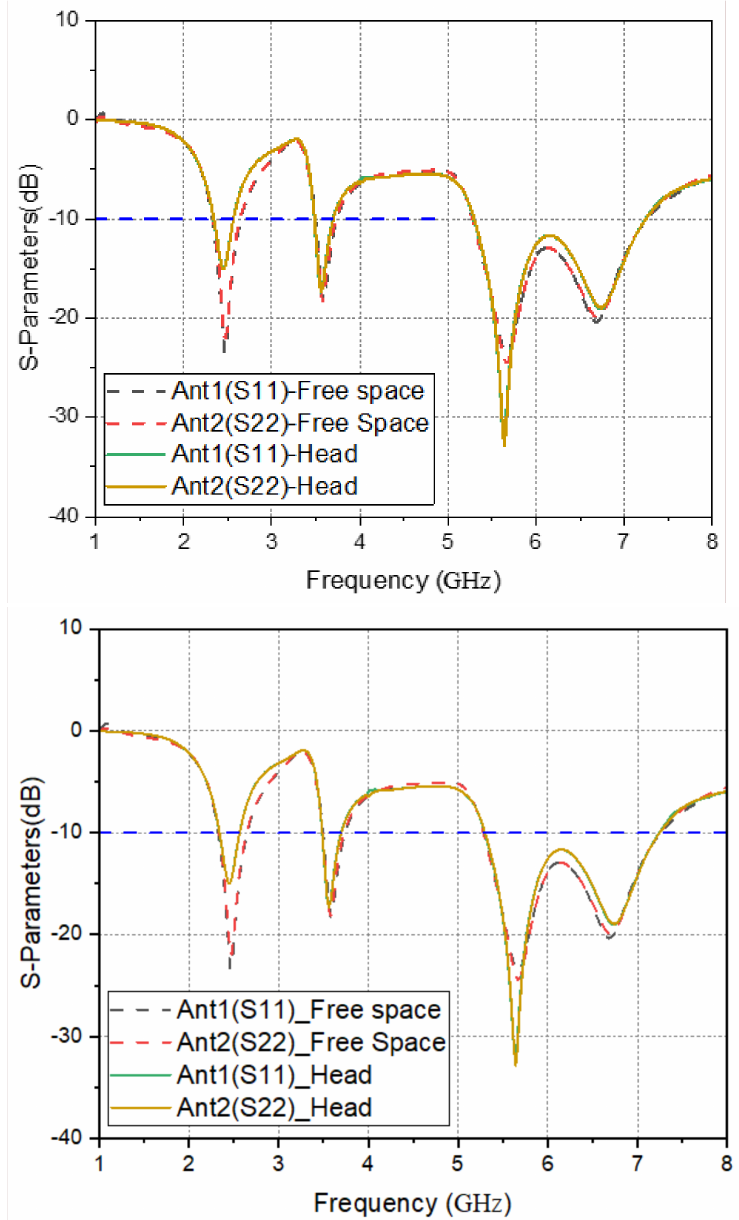
Figure 28. Simulated reflection coefficients of Ant. 1 and Ant. 2 in free space and when worn on the